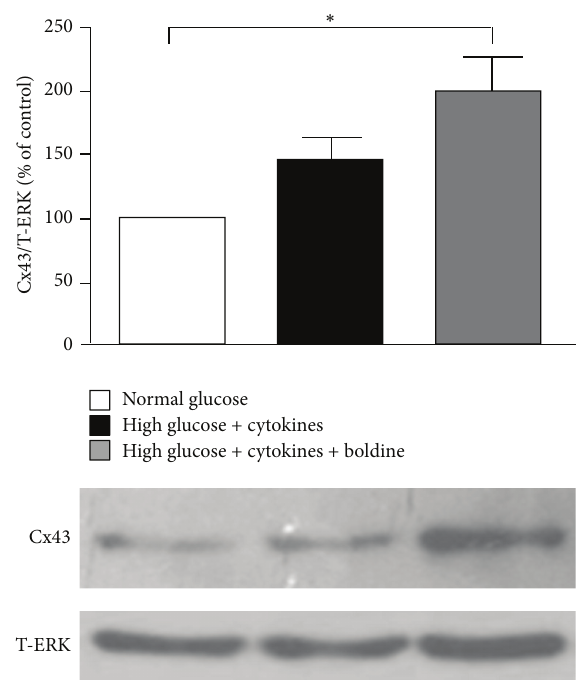
Figure 8: Boldine increases the relative Cx43 levels in mesangial cells grown in high glucose plus proinflammatory cytokines. Graph showing the relative levels of Cx43 under different conditions: nor- mal glucose (white bar), high glucose + proinflammatory cytokines (TNF- 𝛼 (10ng/mL) and IL-1 𝛽 (10ng/mL)) (black bar), or high glucose + cytokines treated with 100 𝜇 M boldine (grey bar) for 24 h. Each bar represents the mean value ± SEM of 4 independent experiments. ∗ 𝑃 ≤ 0.05 , using the one-way ANOVA test followed by Bonferroni’s post hoc